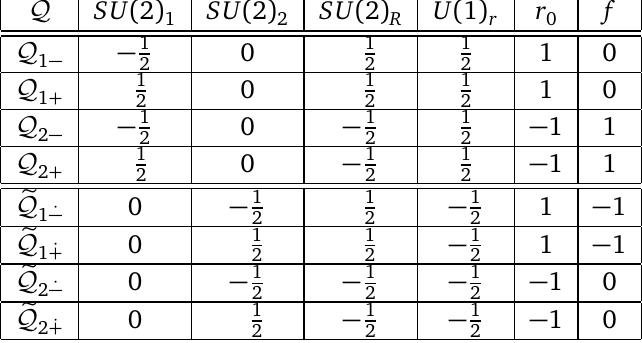
⊗ SU ( 2 ) isometry group, 1 2 ⊗ U ( 1 ) R-symmetry group, r is the 3 d R r 0